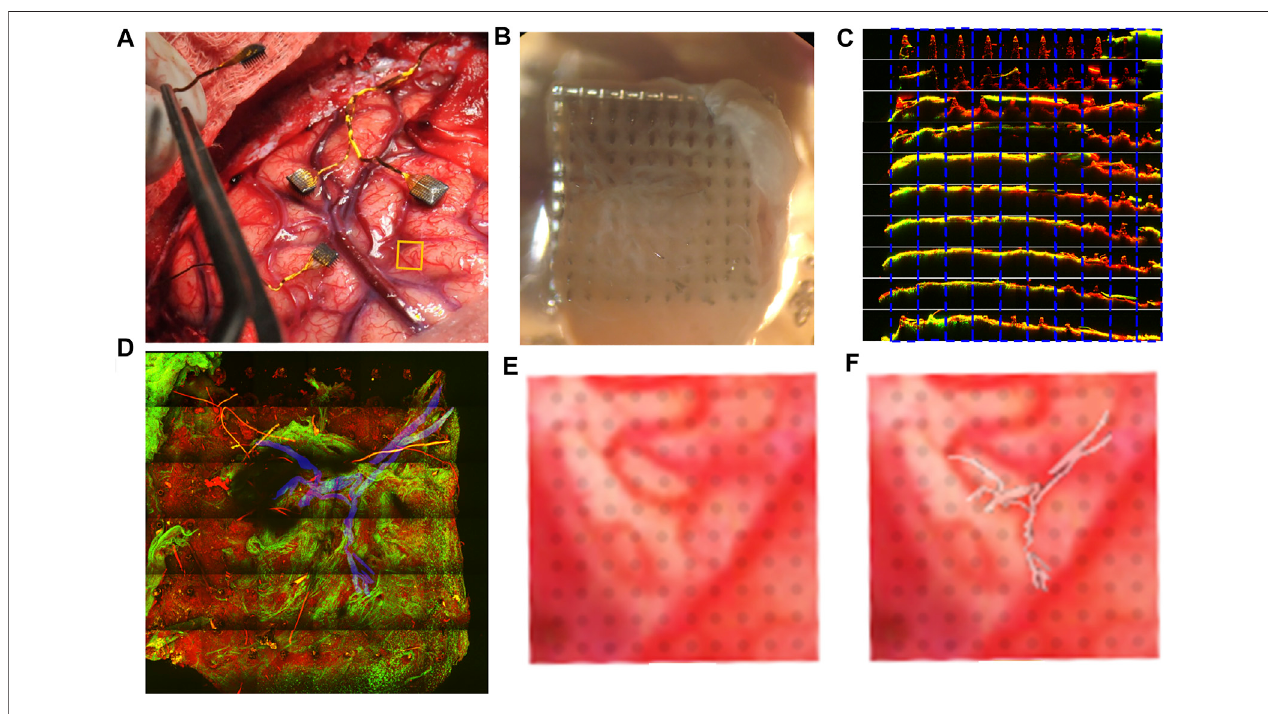
FIGURE 4 | Brain vascularization can be visualized on the medial Pt array from P2. The pre-implant location is indicated with a yellow box (A) . (B) Optical image of the array showing tissue coverage. (C) TPM of the shanks of the electrode, with green denoting second harmonic signal from collagen and red denoting the auto fl uorescence of the device. Each electrode was imaged and separated by row (side view). Most of the electrode tips are covered by collagenous tissue. (D) TPM image of the array looking from the tips downward, with a portion of vasculature marked in blue as determined by SHG imaging. (E) zoomed in image from (A) where electrode shanks are superimposed on the underlying vasculature. (F) The vasculature visualized in (D) is superimposed on (E) , showing similar trajectory, demonstrating that the vasculature structure identi fi ed in the tissue on the explanted array is likely of pial